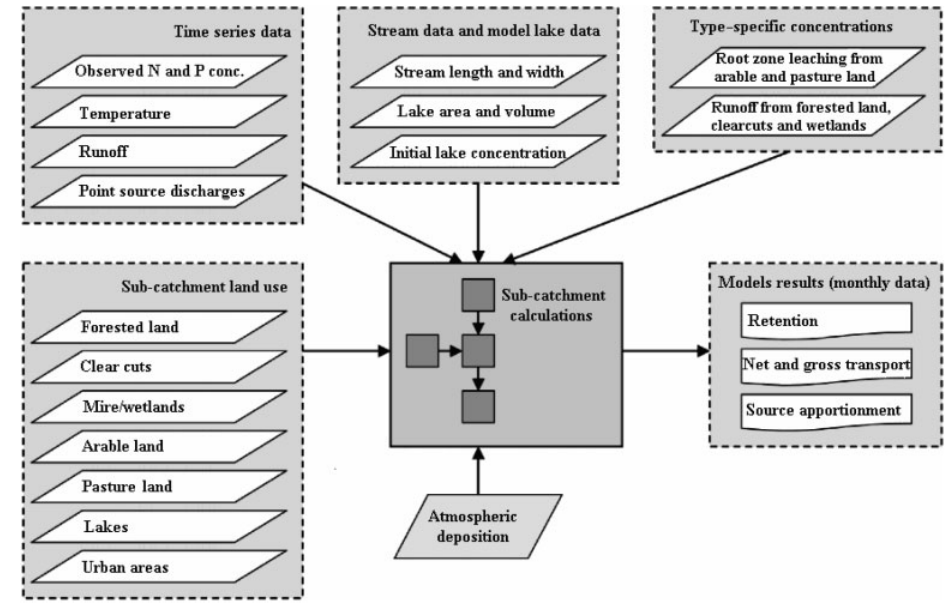
Fig. 2. Structure of FyrisNP model inputs and outputs (Hansson et al. 2008)